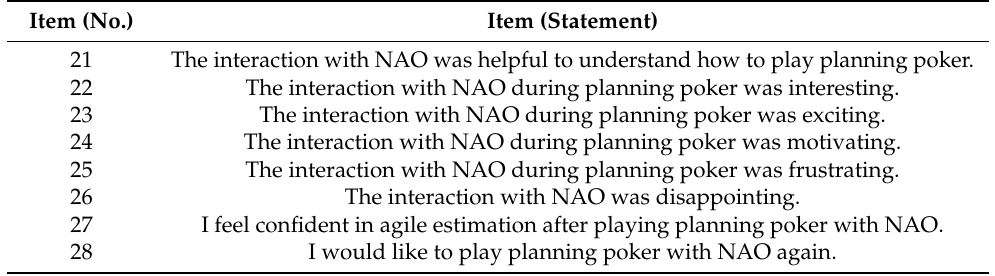
Table 2. Survey items related to the robot-supported learning experience applied in the evaluation study.